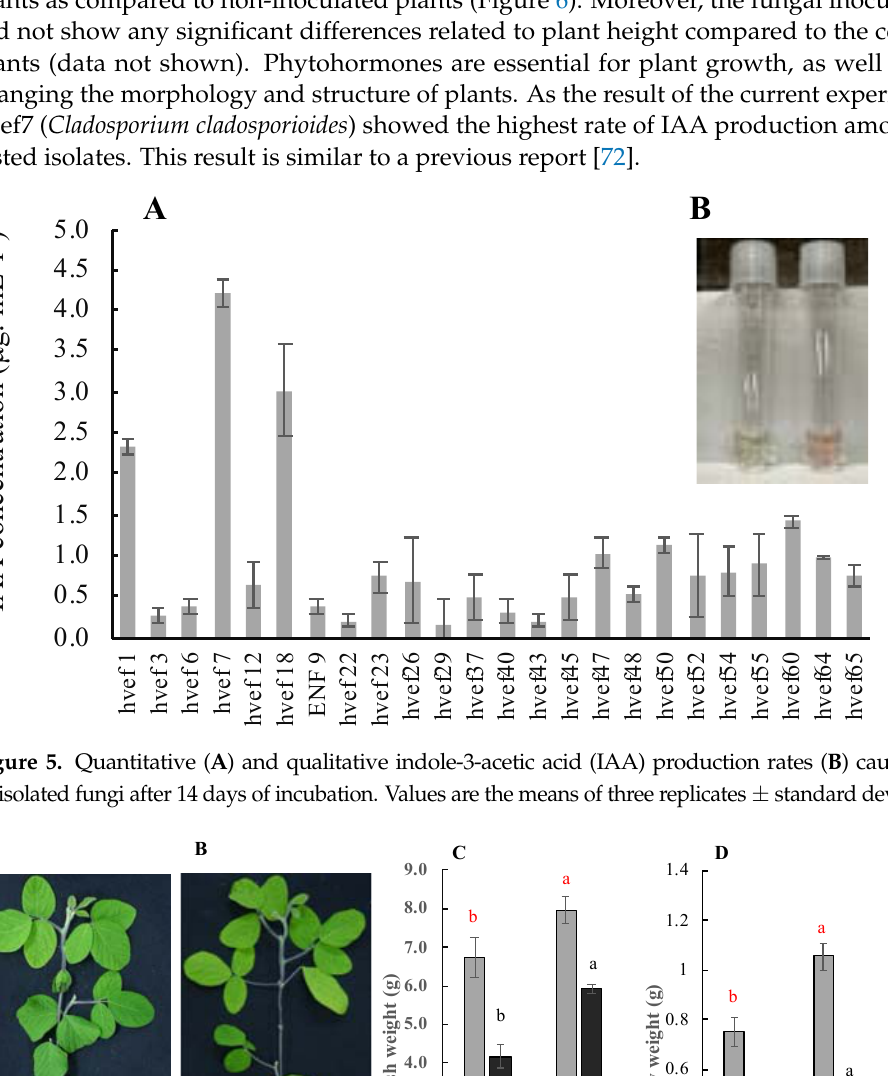
Figure 5. Quantitative ( A ) and qualitative indole ‐ 3 ‐ acetic acid (IAA) production rates ( B ) caused by 24 isolated fungi after 14 days of incubation. Values are the means of three replicates ± standard deviation.